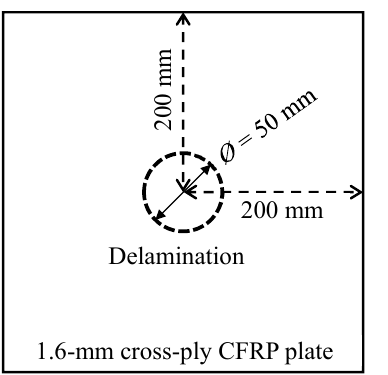
Figure 12. Schematic of a 1.6 mm cross-ply carbon fiber-reinforced polymer (CFRP) composite plate with circular delamination by inserting